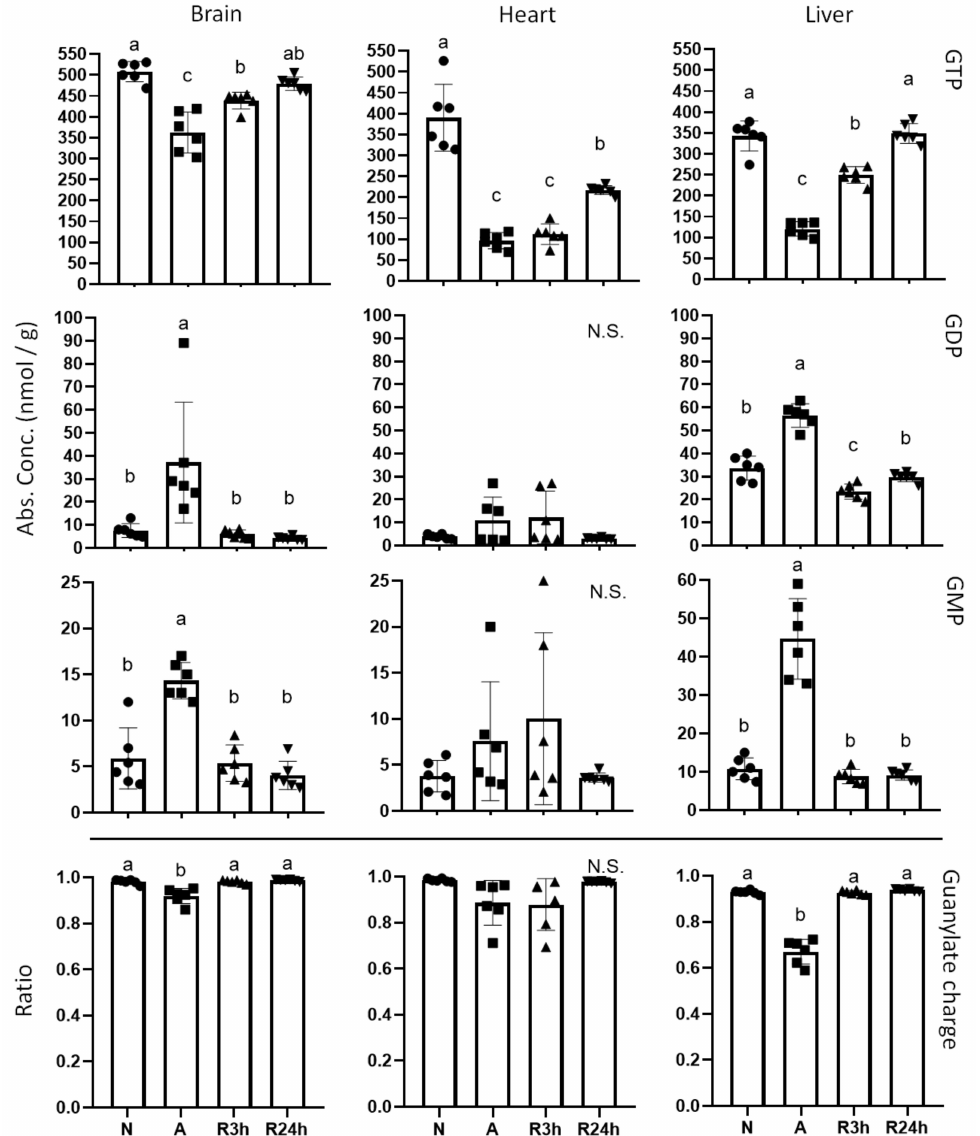
Figure 3. Guanosine phosphates. Graphs of absolute concentrations for GTP, GDP, and GMP of brain, heart, and liver, as well as guanylate charges ([GTP + 1/2GDP]/[GTP + GDP + GMP]). N, normoxia (control); A, anoxia; R3h, 3 h reoxygenation, R24h, 24 h reoxygenation. Different letters indicate statistical differences between groups calculated using one-way ANOVA with Tukey’s post-hoc ( p -value ≤ 0.05). Data are presented as means ± S.D. Values as reported by HMT (Human Metabolome